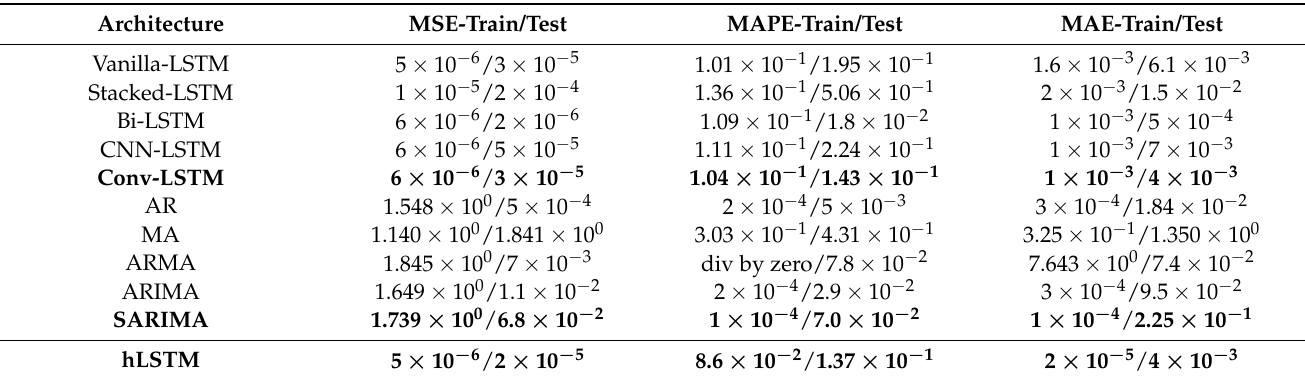
Table 1. Results of evaluation metrics for CPU utilization